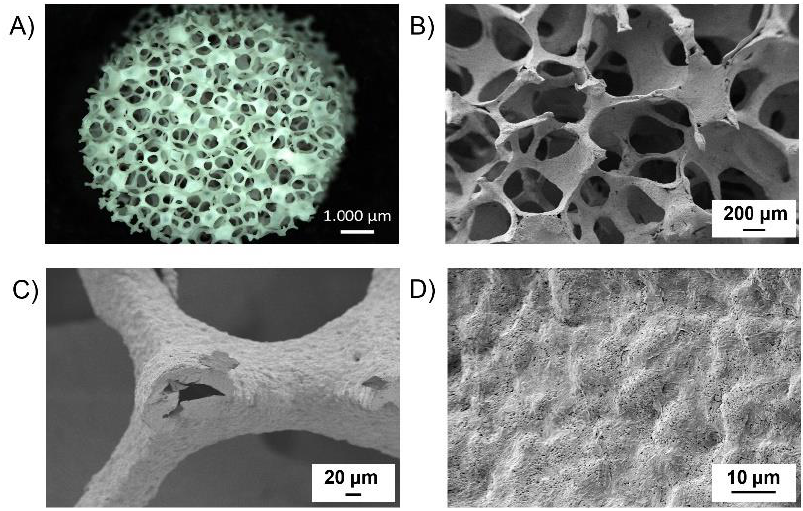
Figure 4. ( A ) Light microscope image and SEM micrographs at ( B ) 70×, ( C ) 500× and ( D ) 3.5k× of Bioglass ® scaffolds. BG